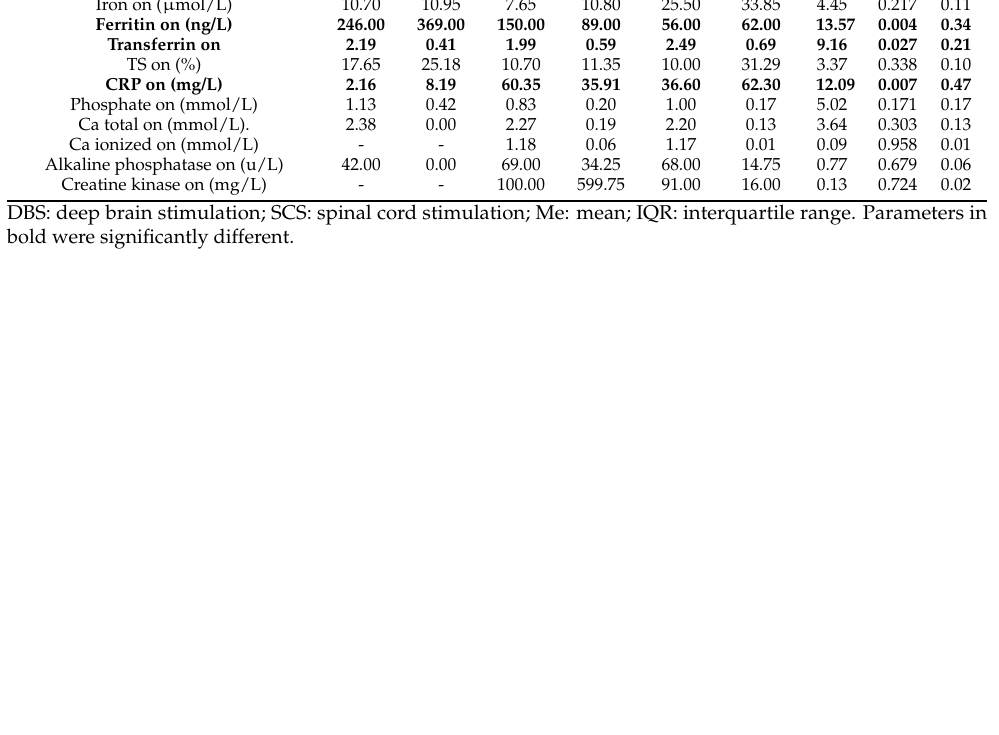
Table 5. Comparison of selected biochemical parameters after electrical stimulation. Lesions Parameters